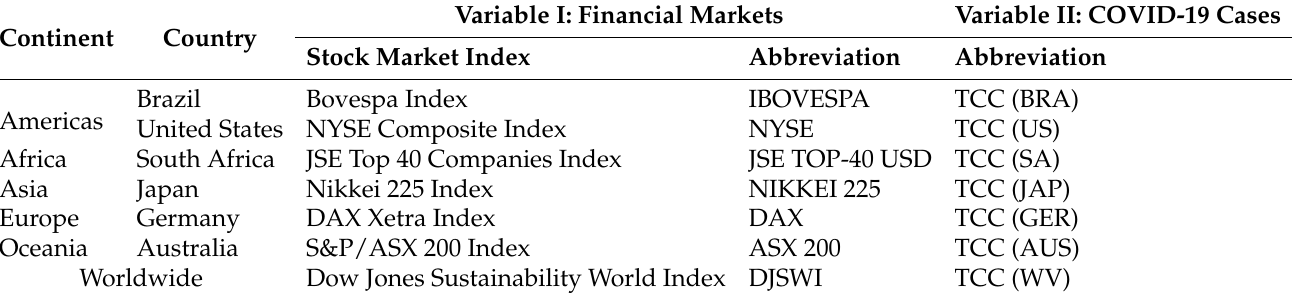
Table 1. Description of the